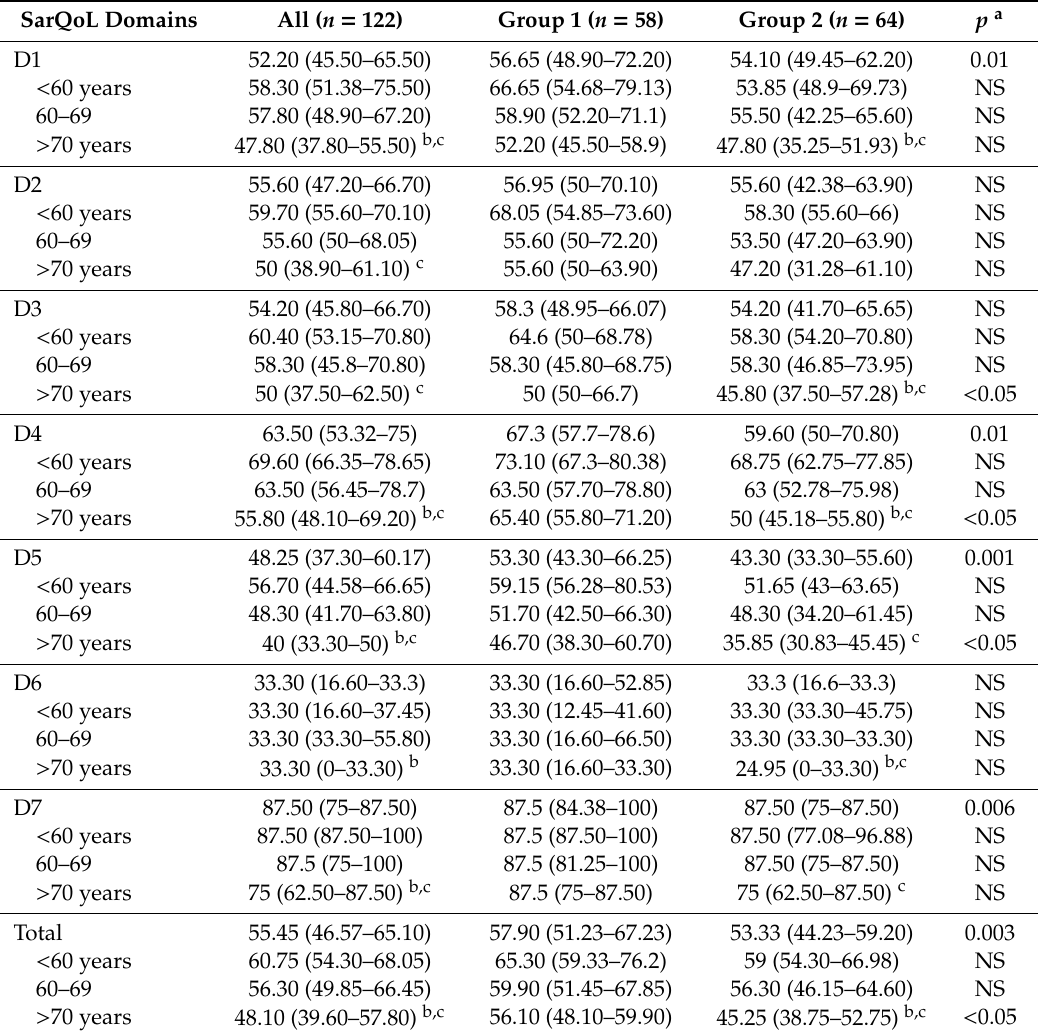
Table 2. Results of the SarQol Questionnaire in the Three Age